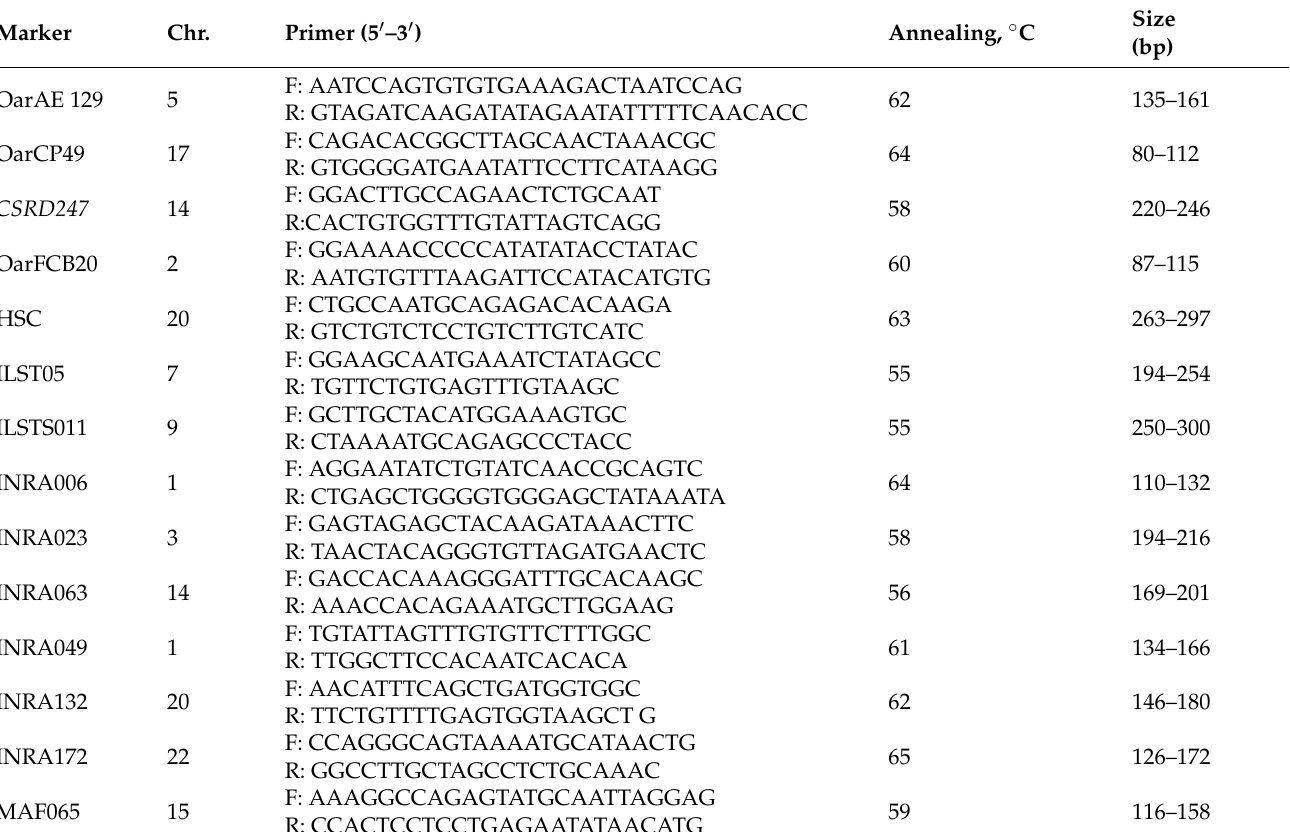
Table 2. Information on the microsatellite markers used in the study (the microsatellite ID, genome position, annealing temperature, and allele length expressed in base